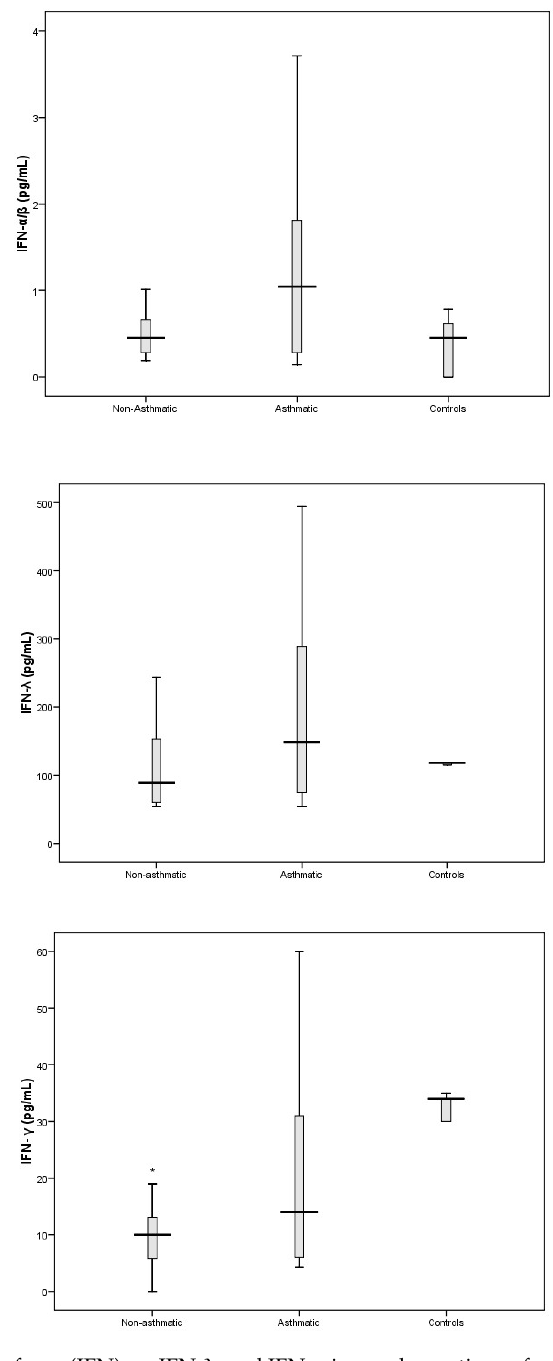
Figure 6. Levels of interferon (IFN)- α, IFN-λ, and IFN-γ in nasal secretions of controls, and hospitalised RV-C-infected patients with asthma and without asthma. IFN-γ was attenuated in the non-asthmatic group to controls. In RV-C-infected children with preexisting asthma, there was a trend towards reduced IFN-γ levels ( p = 0.08). The levels of IFN-λ, and IFN-α were not significantly different in either patient group compared to controls. * p < 0.05.